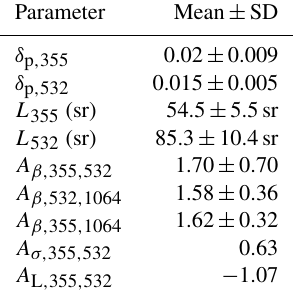
Table 3. Mean values and standard deviations of smoke optical properties computed from the time series in Fig. 15. Up to 151 daily observations from the beginning of October 2019 to mid- March 2020 are considered. δ p denotes the particle linear depo- larization ratio (PLDR). In the case of the lidar ratio L , at 355 and 532nm, we considered only high-quality observations (showing low noise impact, 46d for L 355 , and 36d for L 532 ). The Ångström exponents for the lidar ratio (Å L ) and the extinction coefficient (Å σ ) are calculated from the mean values of L 355 and L 532 in Fig. 15 and the mean values of σ 355 and σ 532 in Fig.